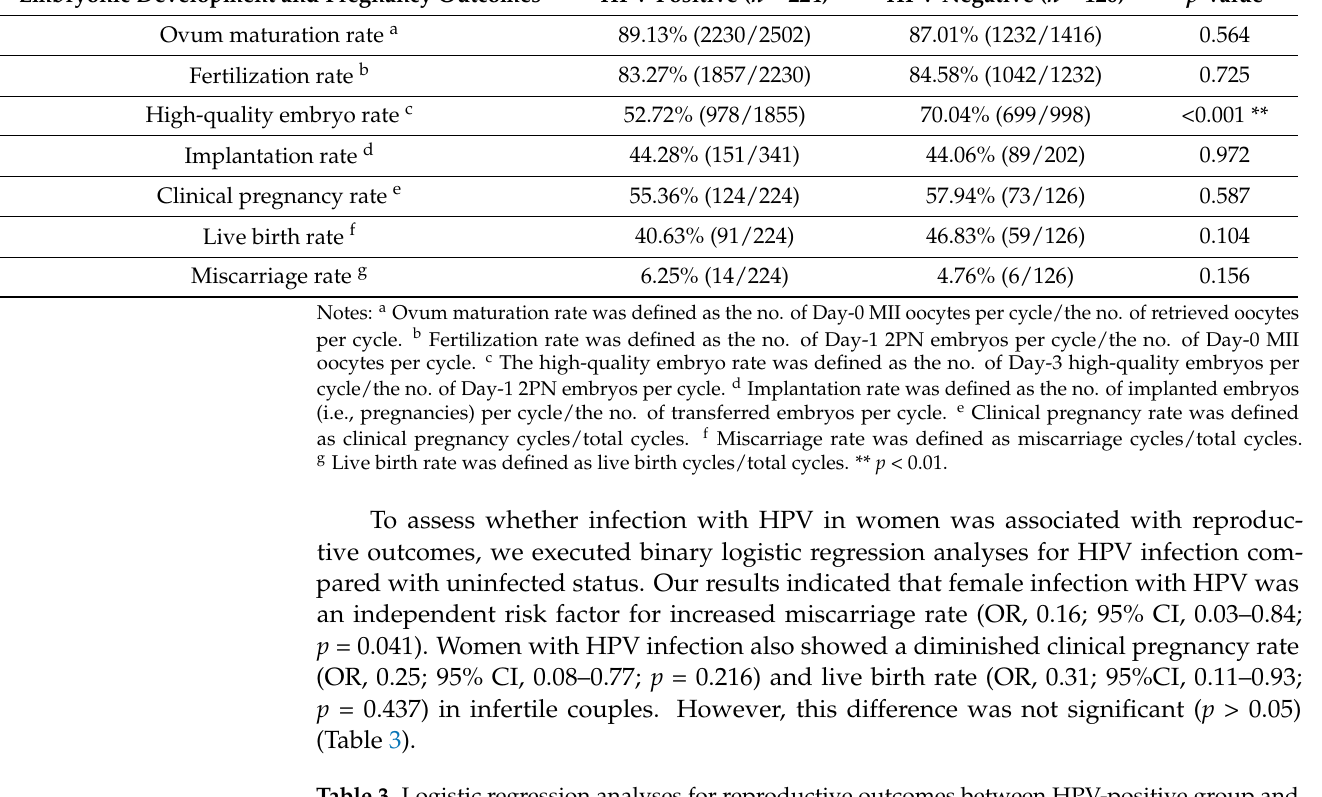
Table 3. Logistic regression analyses for reproductive outcomes between HPV-positive group and HPV-negative